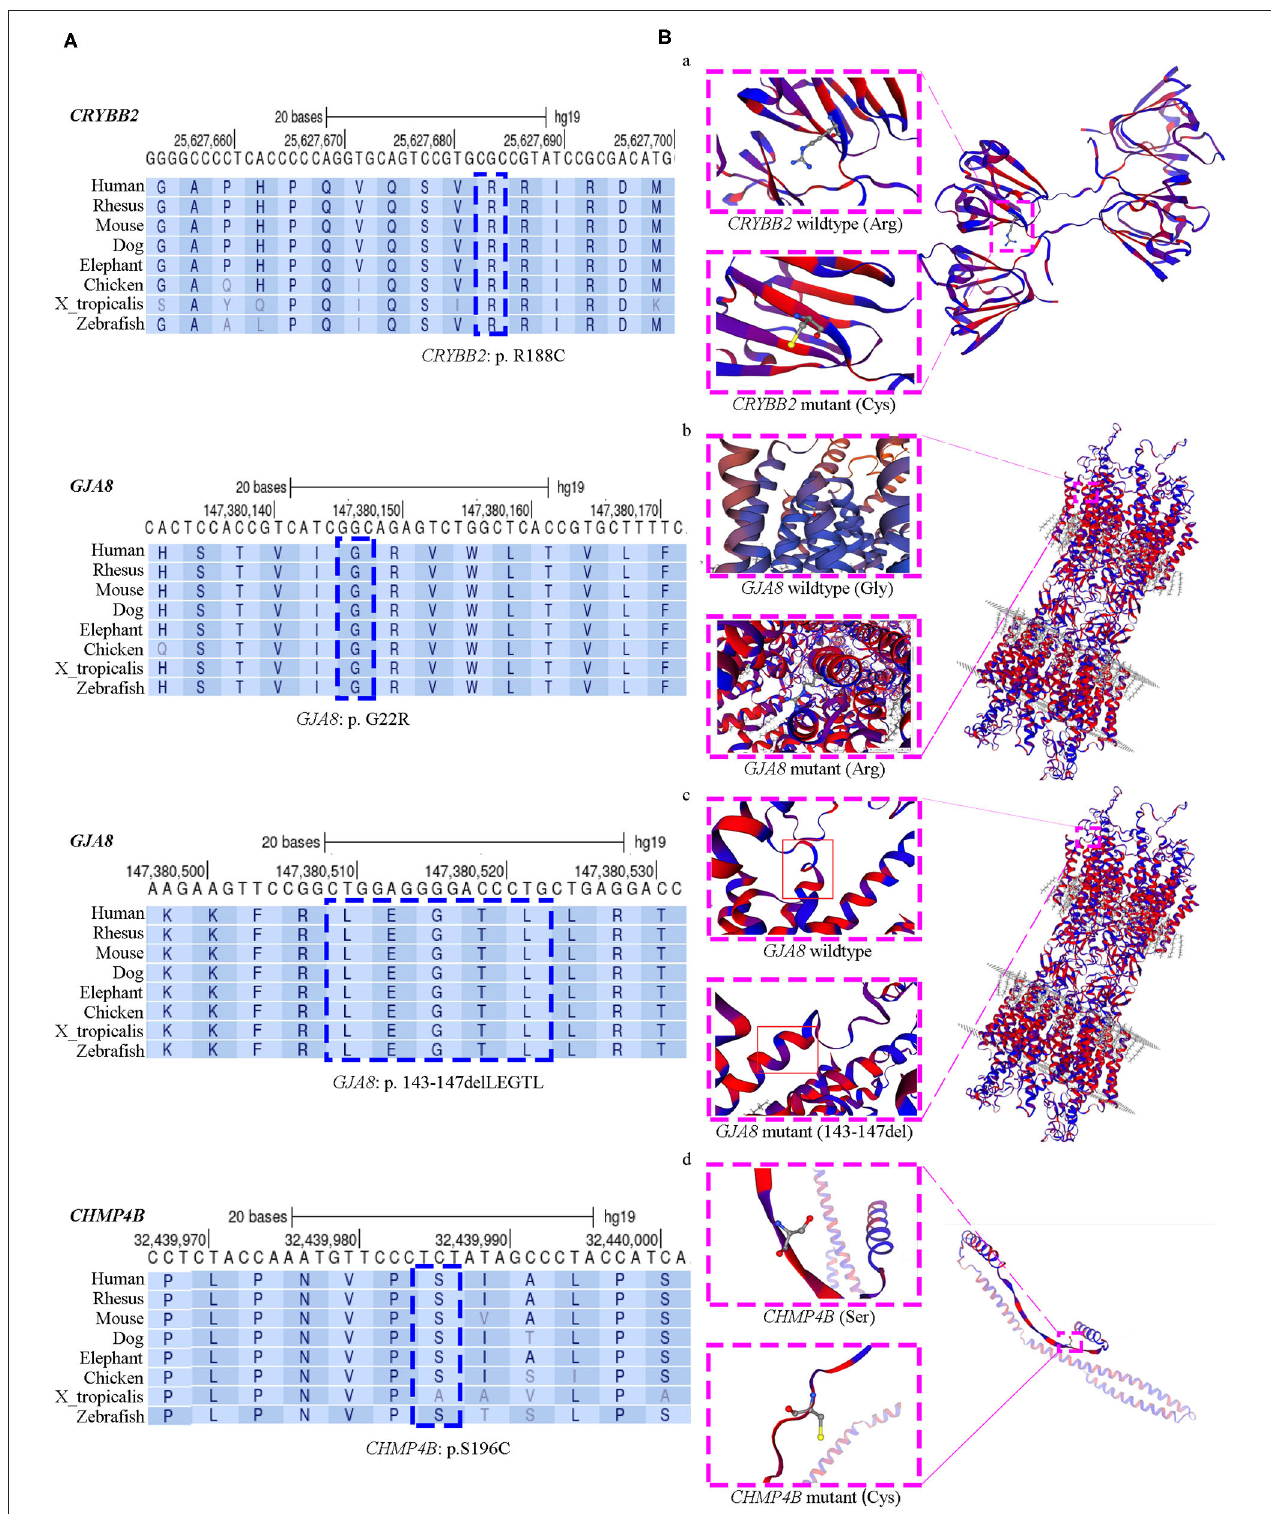
FIGURE 2 | Evolutionary sequence conservation analysis and structure homology modeling of mutant proteins and native proteins. (A) Multiplex sequence alignment of the β B2-crystalline protein, connexin 50, and the chromatin-modifying protein 4b from different species reveals that the four mutation ( CRYBB2 : R188C, GJA8 : G22R, GJA8